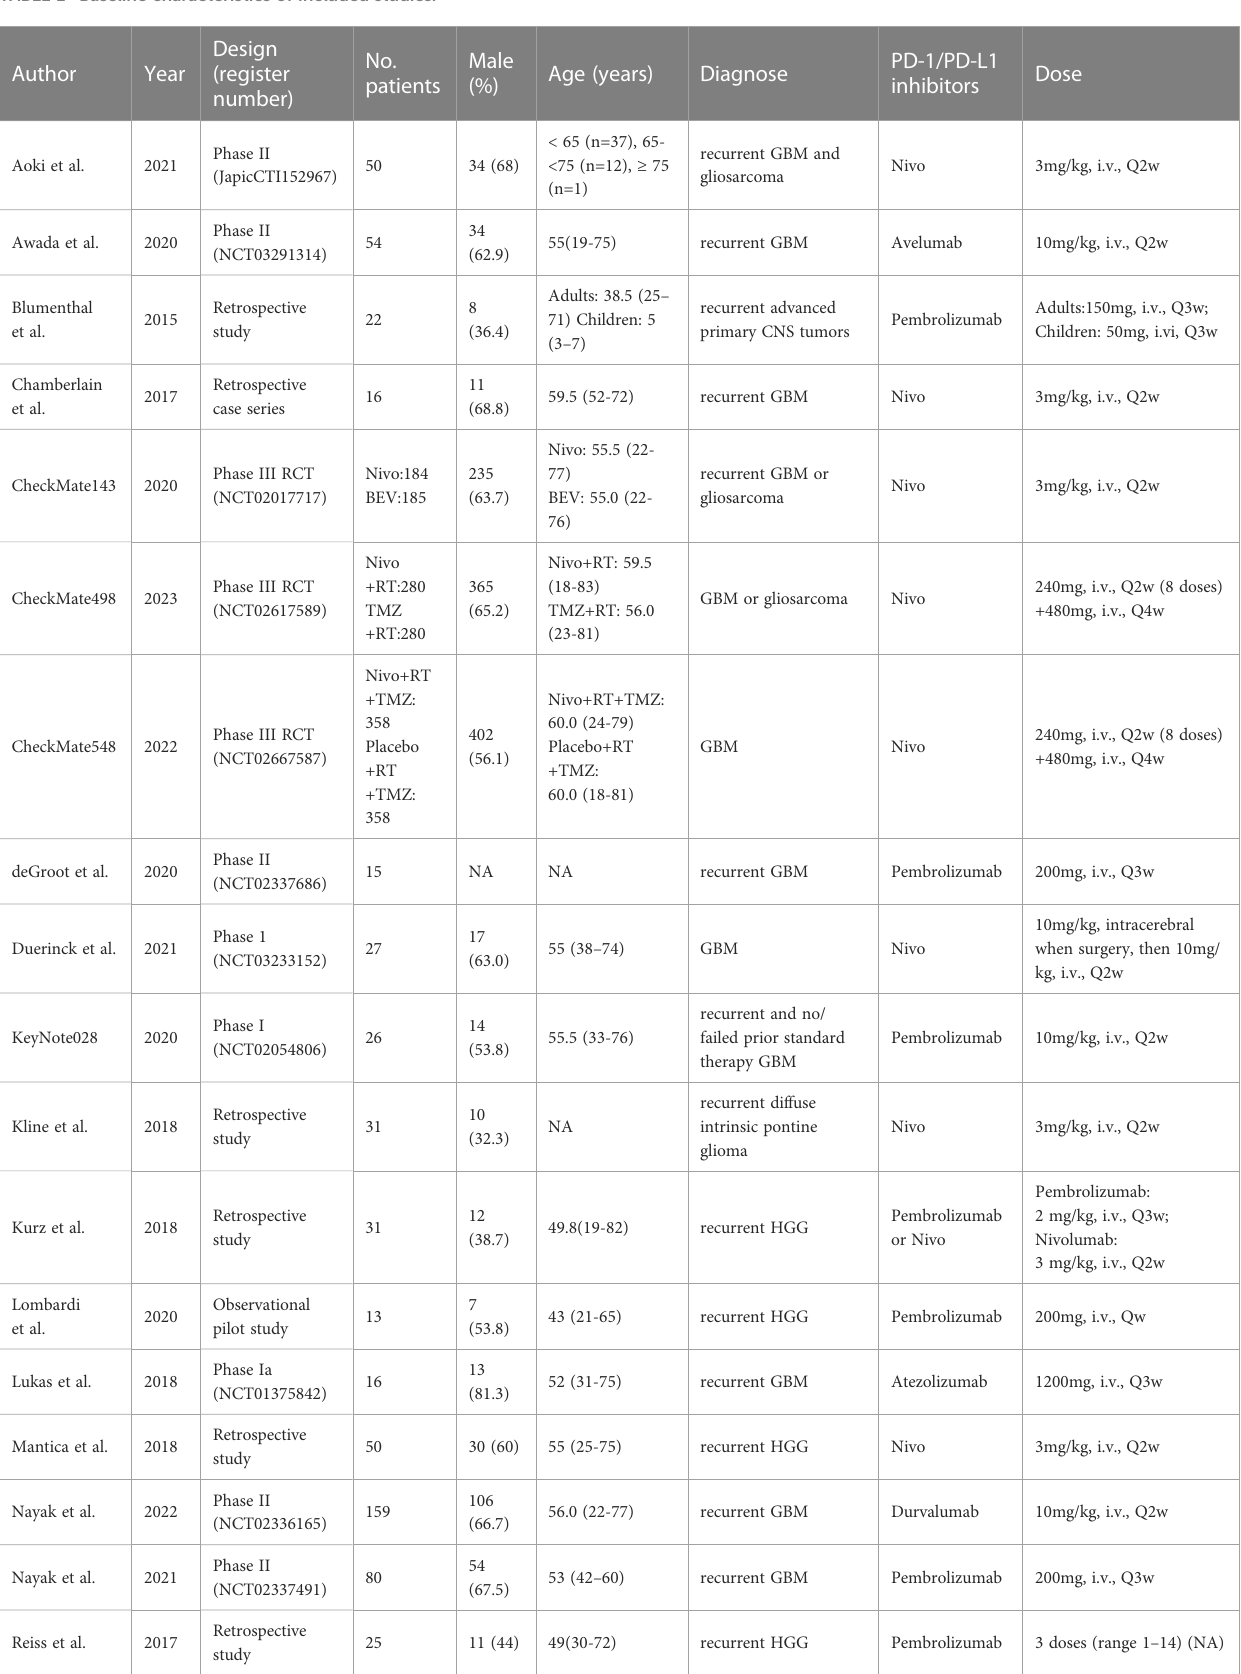
TABLE 1 Baseline characteristics of included